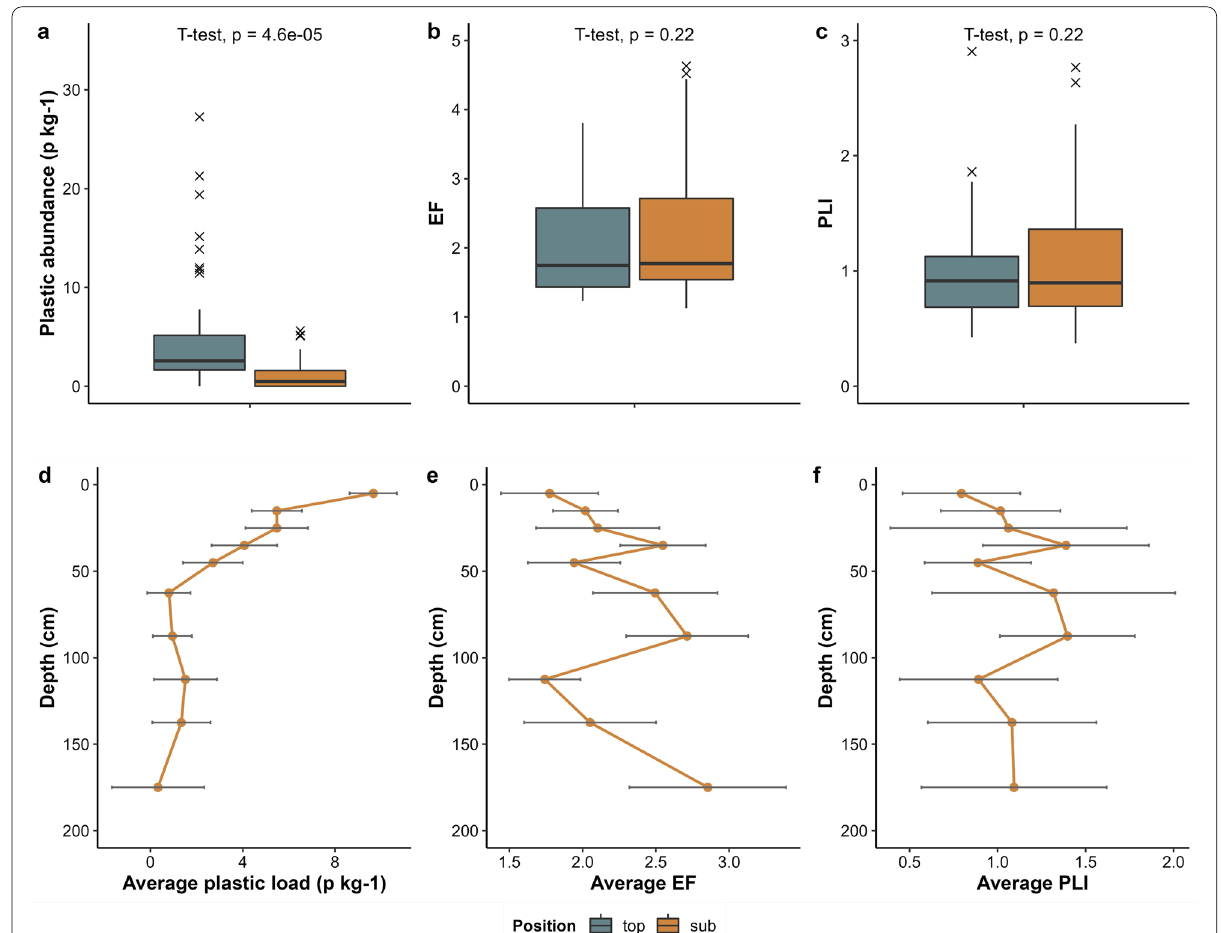
Fig. 5 Vertical spatial differences for plastics and metal contaminations expressed through EF and PLI values. a Plastic abundance (p kg − 1 ) for upper soil layer (0–50 cm, n 50) and subsoil layer (50–200 cm, n 50); b EF for upper soil layer (0–50 cm, n 50) and subsoil layer (50–200 cm, = = = n 50); c PLI for upper soil layer (0–50 cm, n 50) and subsoil layer (50–200 cm, n 50); d Average plastic loads (p kg − 1 ) along the sampled depth = = = gradient ( n 10 per depth section); e Average EF along the sampled depth gradient ( n 10 per depth section); f Average PLI along the sampled = = depth gradient ( n 10 per depth =